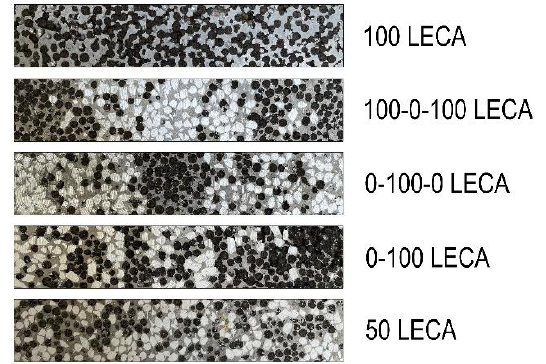
Figure 2. Samples for modal analysis with different layering.